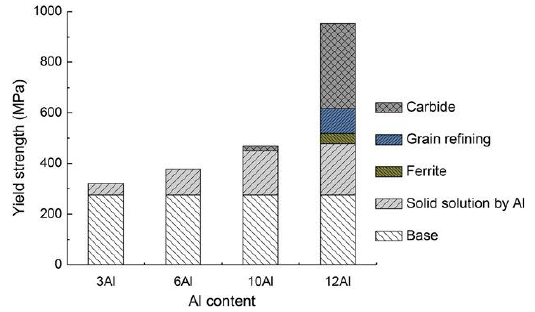
Figure 5. Diagram indicating the different mechanisms contributing to the yield strength of Fe-26Mn- xAl-1C steels. (Reprinted with permission from [66] , copyright Wiley,